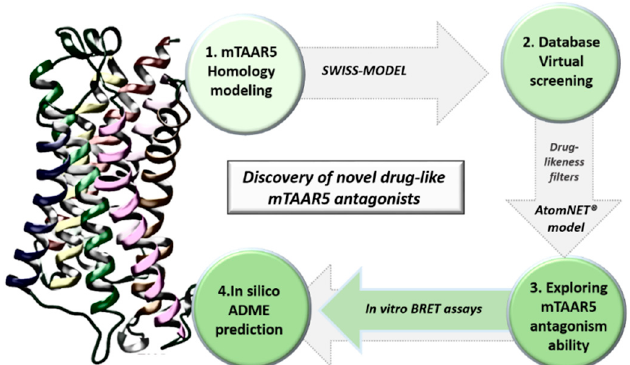
Figure 1. Scheme of the applied screening protocol followed by biological assays and in silico ADME predictive tools.